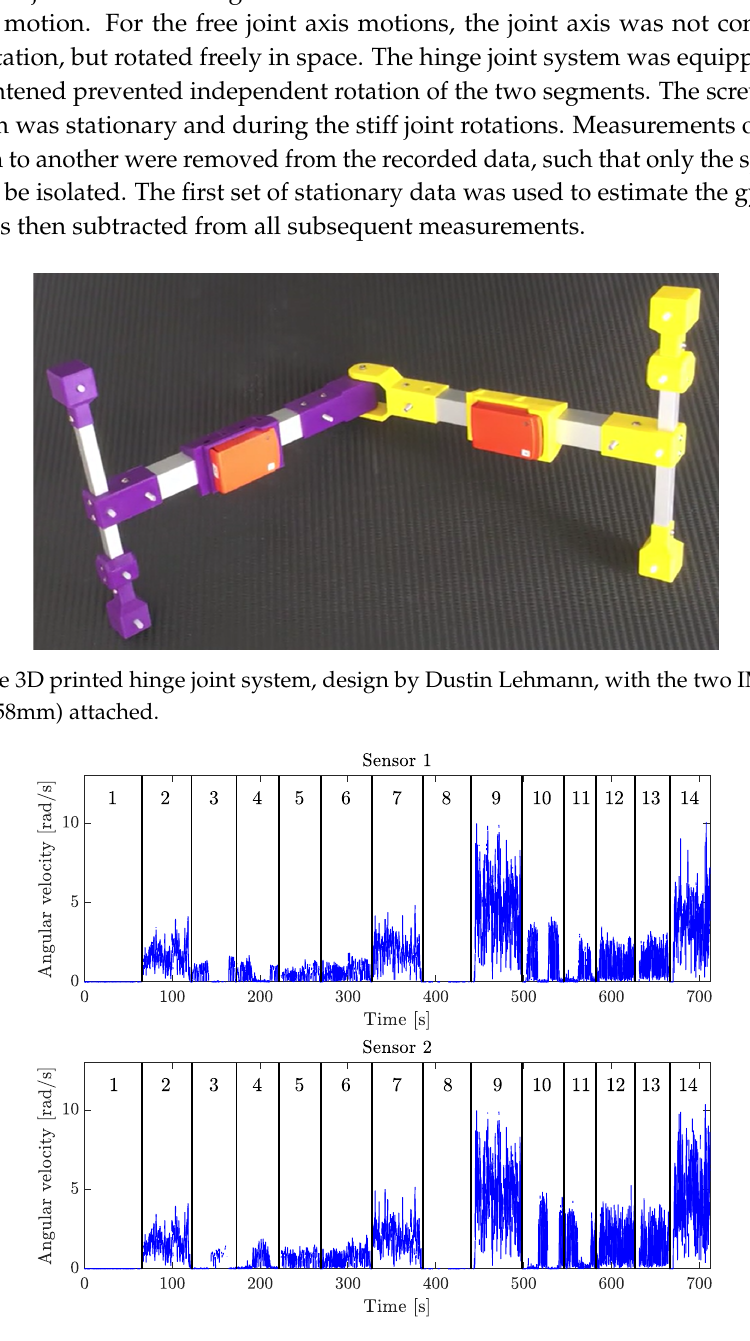
Figure 4. The angular velocity magnitudes for the 14 different motions that were recorded. The vertical lines and numbered sections indicate when the different motions begin and